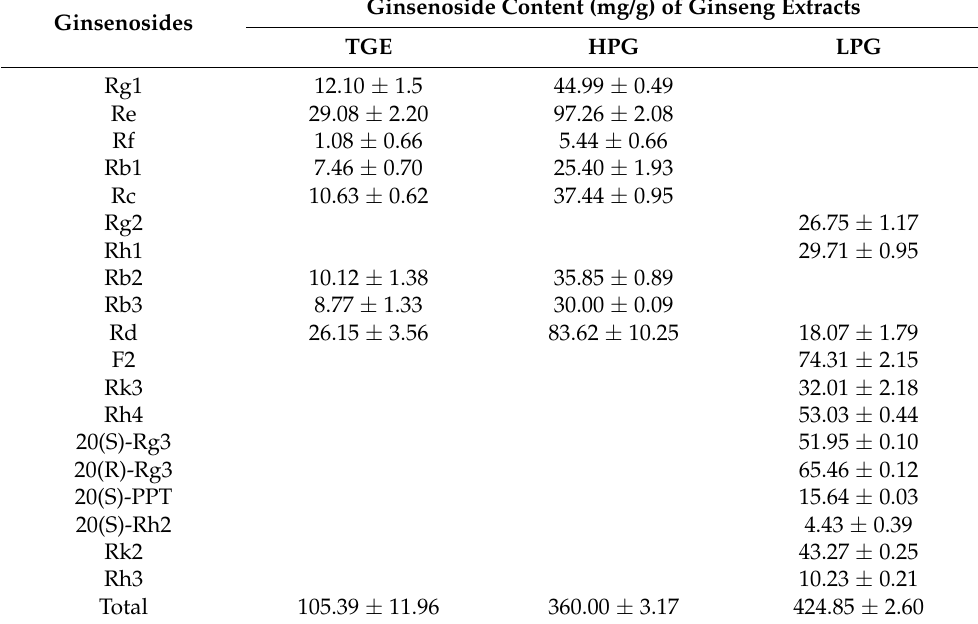
Table 1. Ginsenoside content (mg/g) in the TGE, HPG, and LPG extracts. Ginsenosides